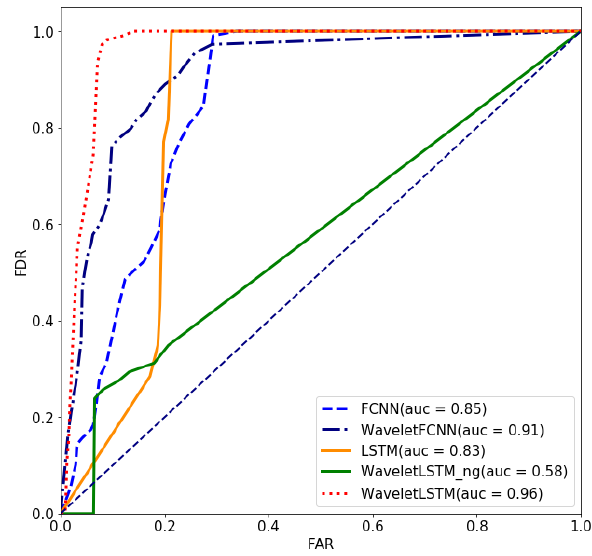
Figure 8. Performance comparison of different